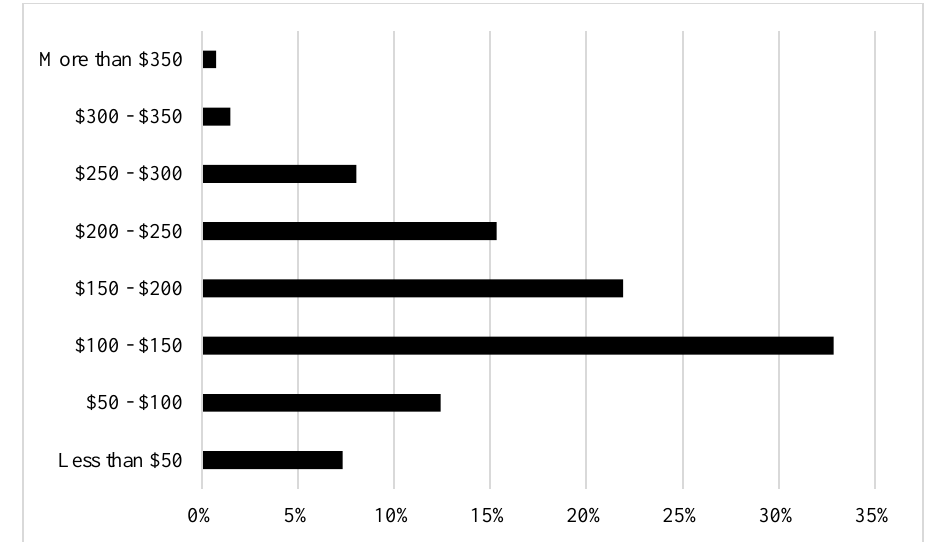
Figure 3 . Faculty prediction of students’ costs related to textbooks per